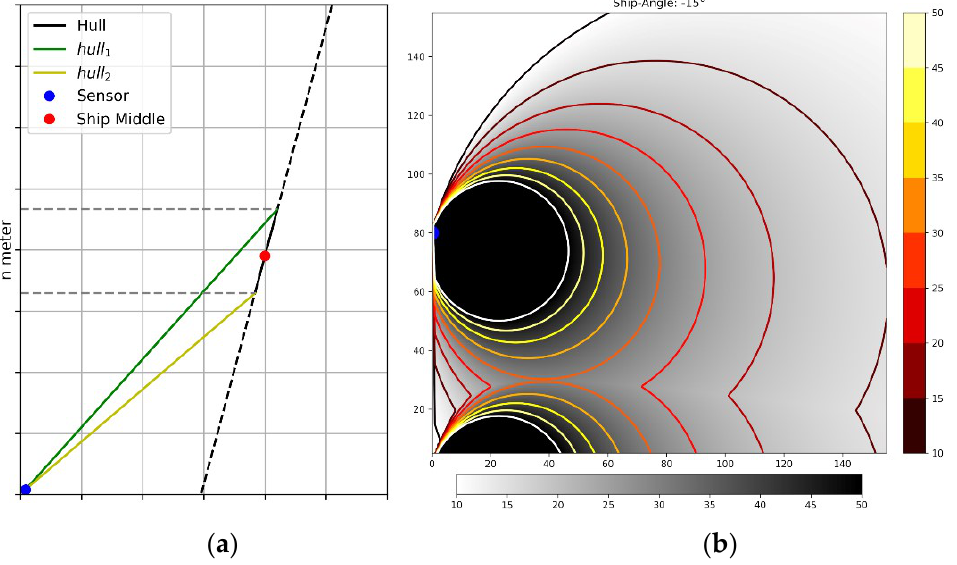
Figure 8. ( a ) Relationship between sensor position, ship-angle, and section width. ( b ) Contour-map of the number of rays that hit a section surrounding each position on the map.